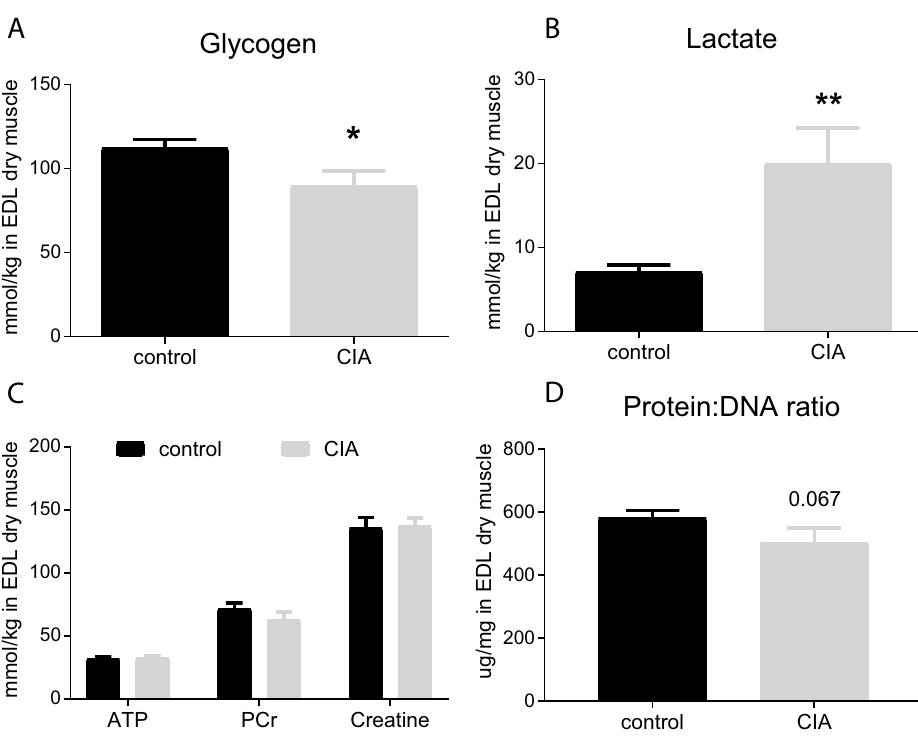
Fig 3. Muscle glycogen, intermediary metabolites and the protein: DNA ratio in the EDL muscle (n = 9 each group). Muscle glycogen content (A) was less and lactate (B) content greater in the EDL of CIA rats compared to control. In contrast, ATP, phosphocreatine (PCr) and creatine (Cr) content remained stable, indicating muscle viability in both groups (C). The alkaline-soluble protein: DNA ratio in CIA group tended to be lower than in control (D). Results represent mean ± SEM. � p < 0.05, �� p < 0.01, significantly different from control.